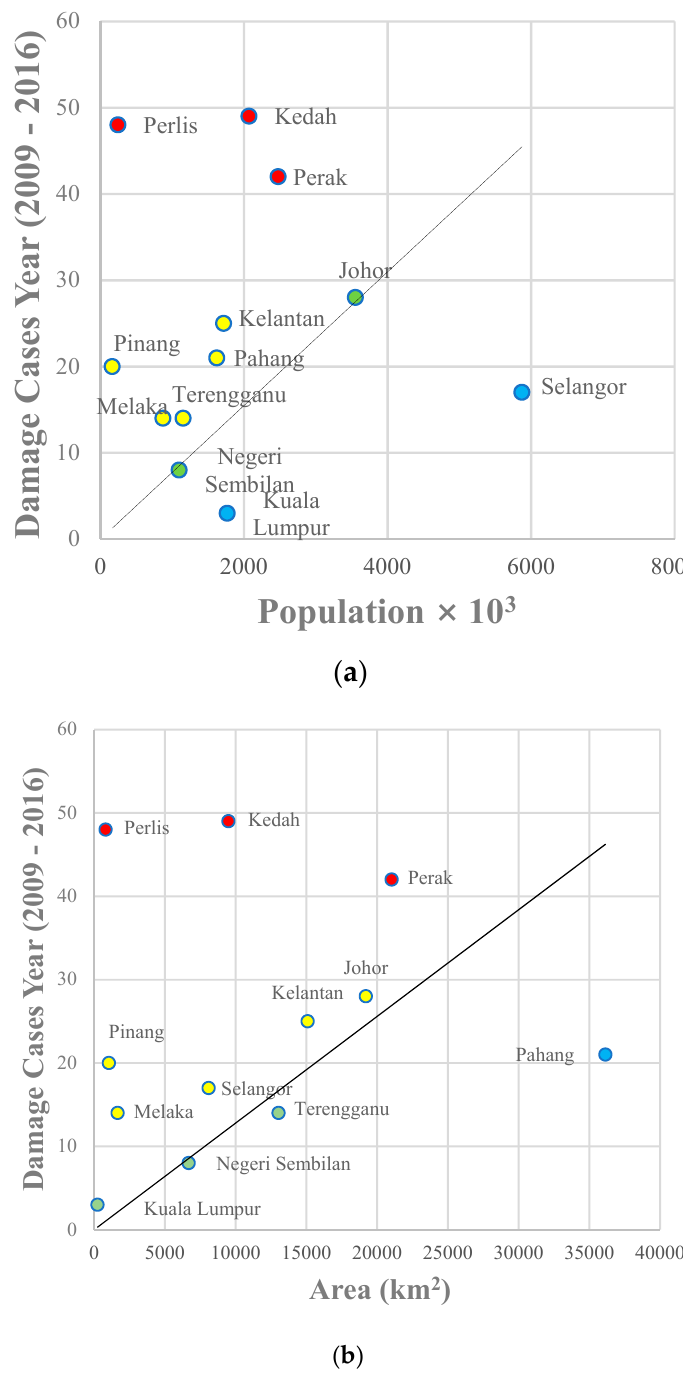
Figure 4. Relationship between windstorm damage and ( a ) population; ( b ) area.